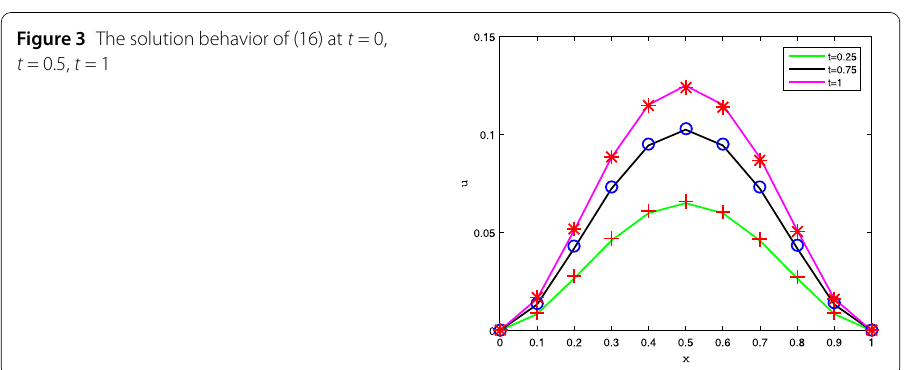
Figure 3 The solution behavior of (16) at t = 0, t = 0.5, t =